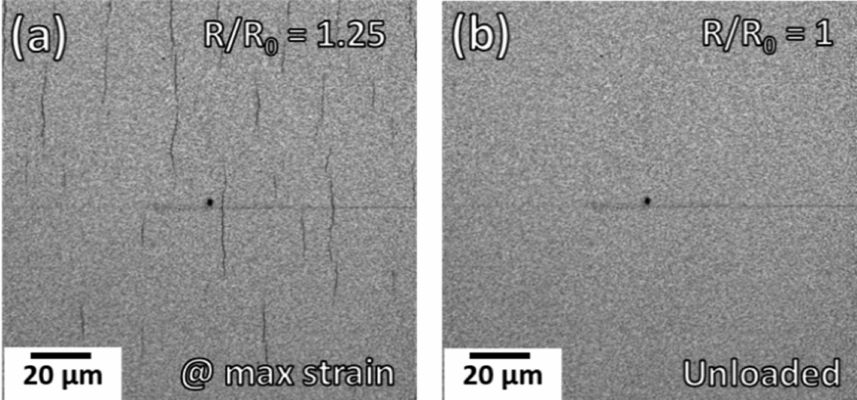
Figure 7. CLSM laser intensity images of a printed Ag film at ( a ) a maximum applied strain of 2% having open cracks (black lines) with R / R 0 = 1.25. ( b ) Removing the load returns the R / R 0 back to its original value of 1 and cracks are no longer visible. (Images courtesy of O. Glushko.).